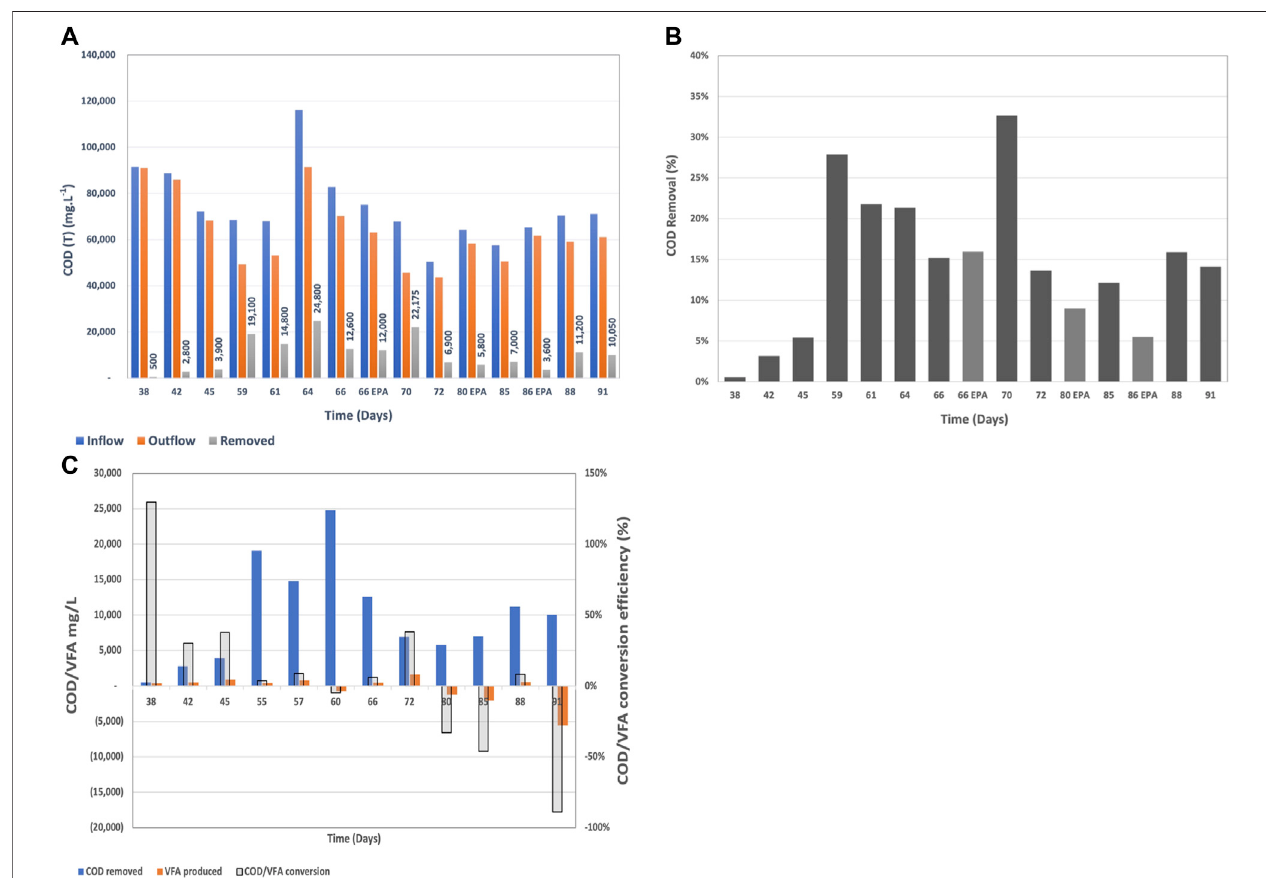
FIGURE3|(A) In fl ow,out fl owCODloadingandCODremovalrateinmg/Lperday, (B) CODremovalrateinpercentagefromthein fl owCODloading,and (C) COD to VFA conversion ef fi ciency and removal during continuous